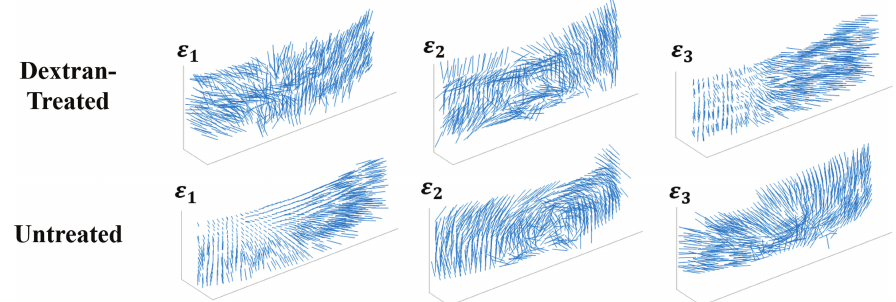
Fig. 6. Vector plots of the orientation of the three principal strains ( " 1 , " 2 , " 3 ) on a spherical surface selected from the mid-stroma of the dextran-treated and untreated corneas after in°ation from 10 mmHg to 12